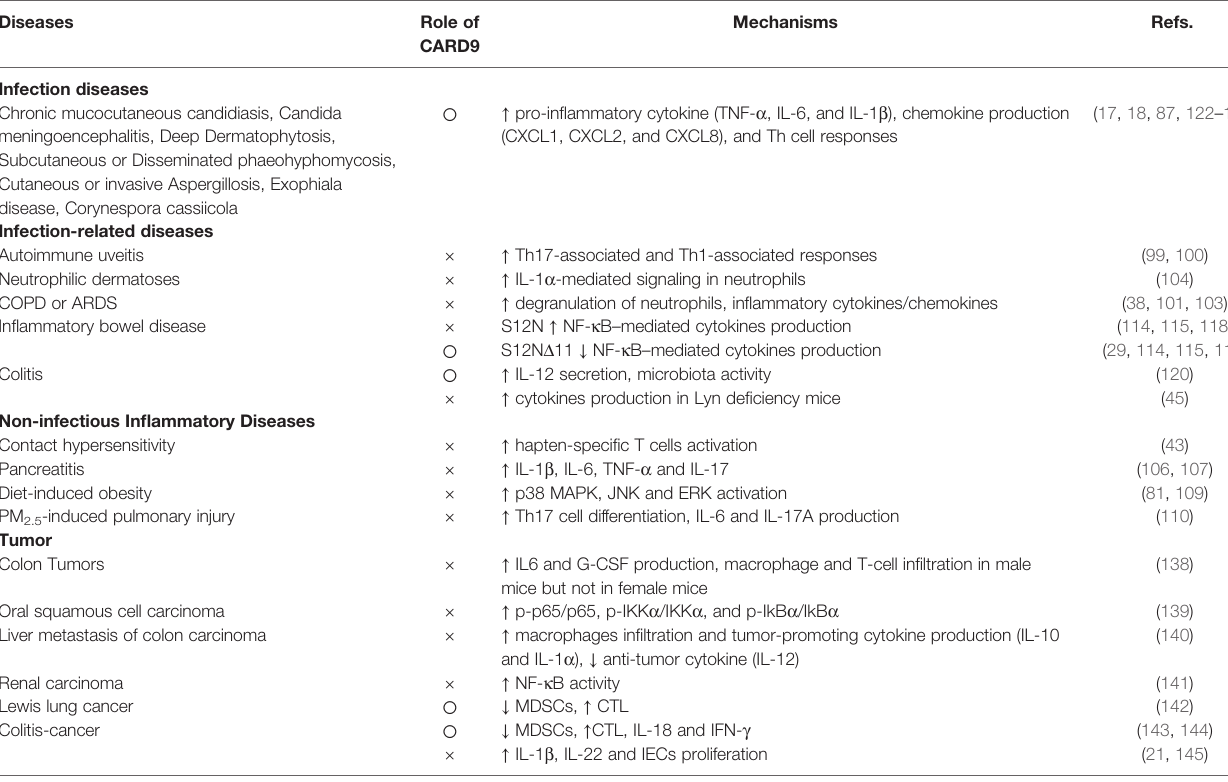
TABLE 2 | The role of CARD9 in different diseases and associated mechanisms. Diseases Role of CARD9